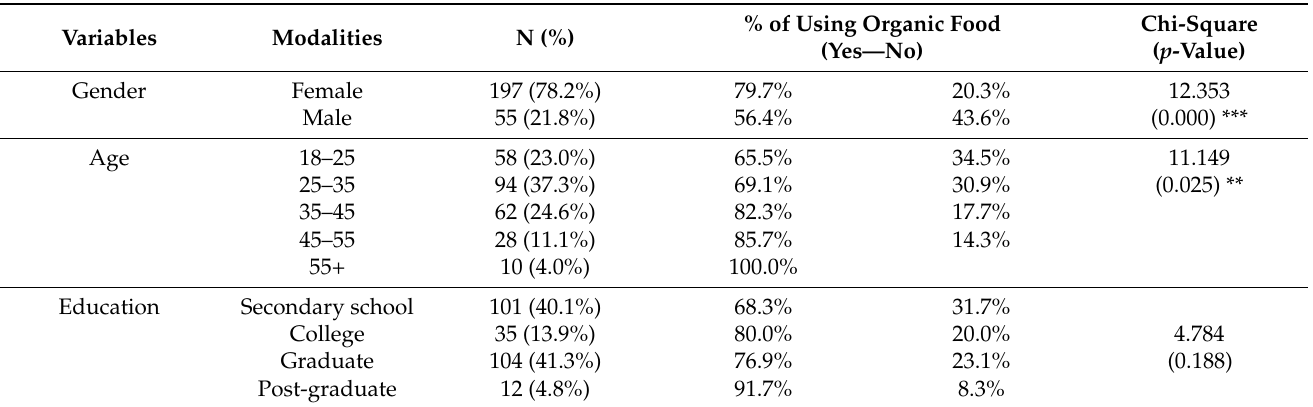
Table A1. Sample Characteristics.